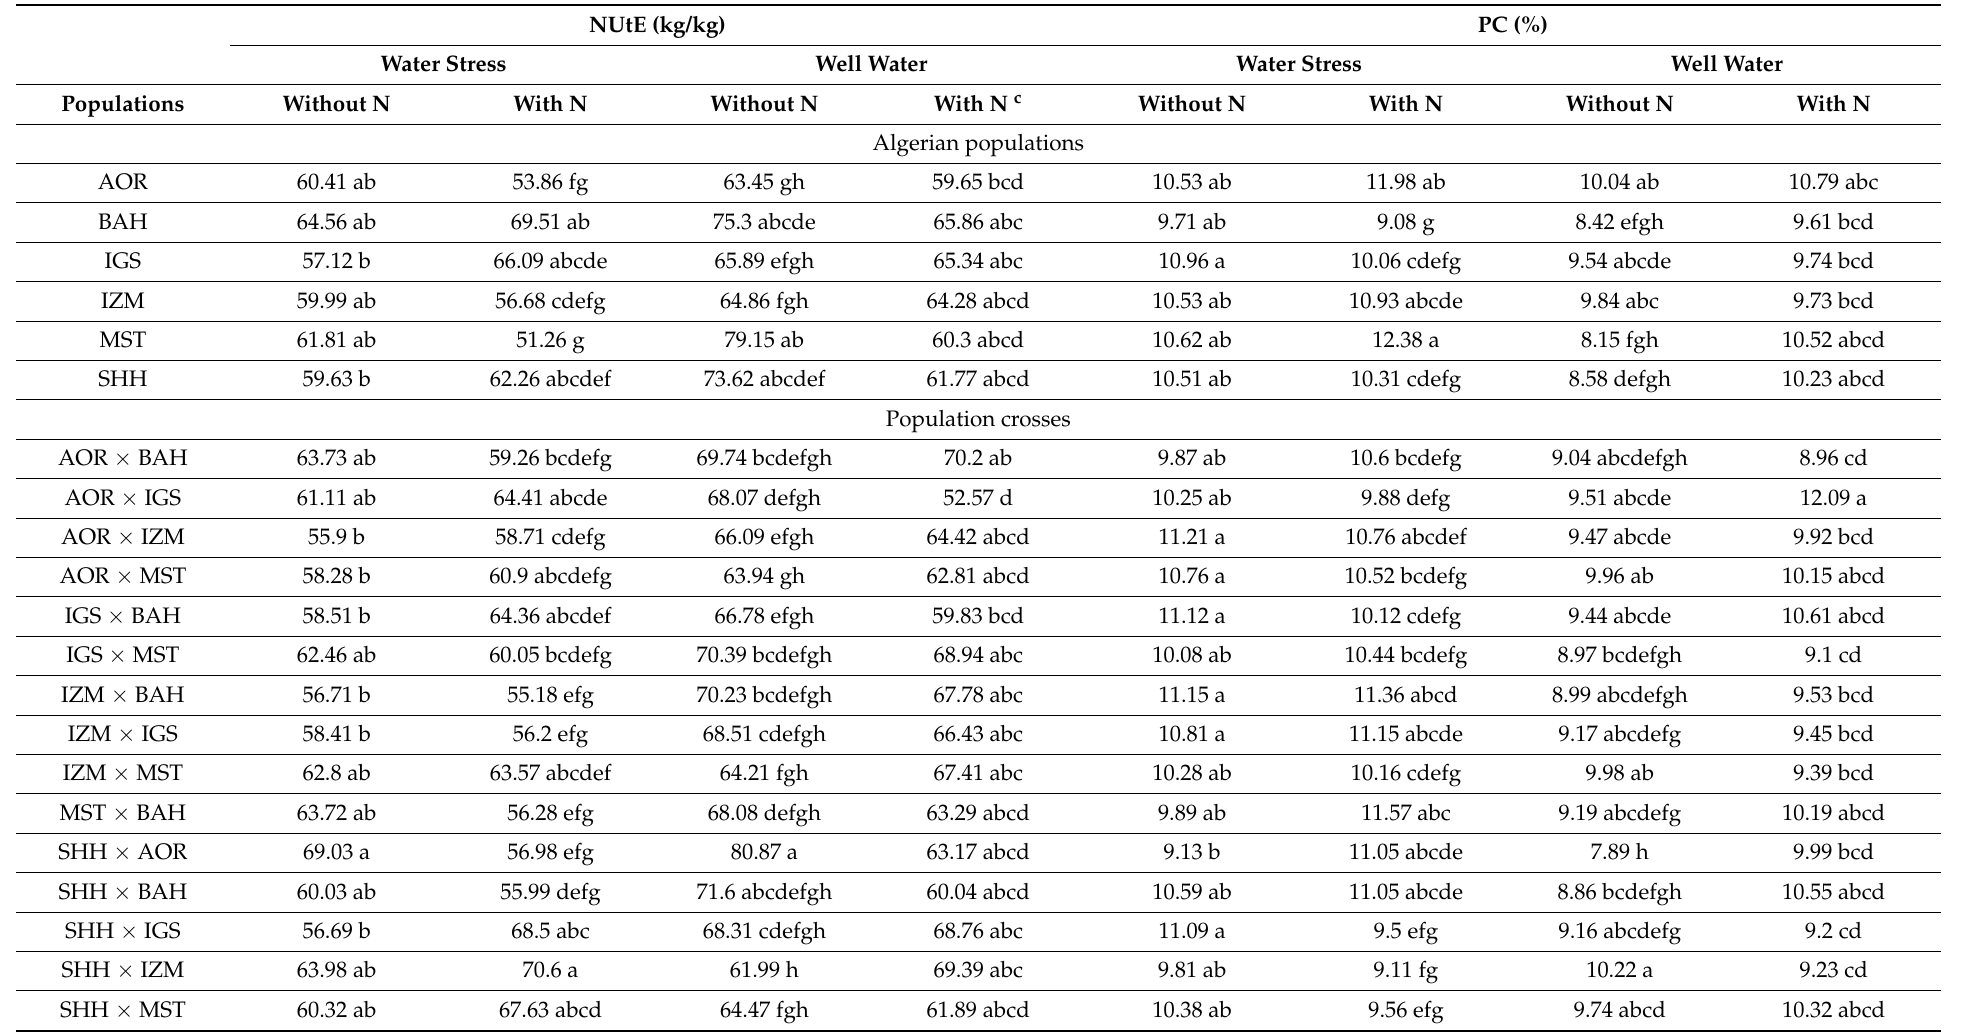
Table 5. Means a of grain protein content (PC) and nutrient utilization efficiency (NUtE) analyzed in the diallel systems with six Algerian maize populations evaluated along with four checks in two environments in Algiers under drought and nitrogen deficiency. NUtE (kg/kg) PC (%) Water Stress Well Water Water Stress Well Water With N Without N With N c Without N With N Without N With